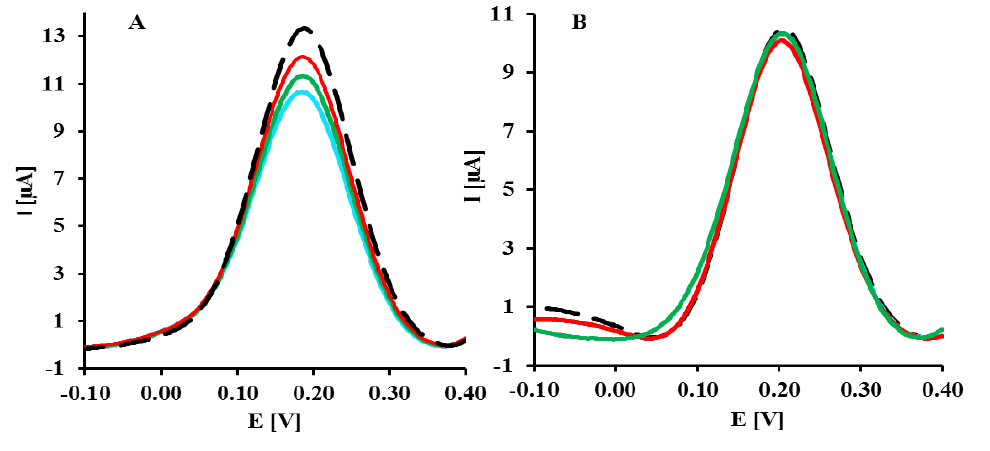
Figure 6. The relationship of I = (I (■) C - . I is the value of peak current after detection of given concentration of target, and I n is the value of peak current without presence of target in pure 0.1 M PBS pH 7.4 (n =